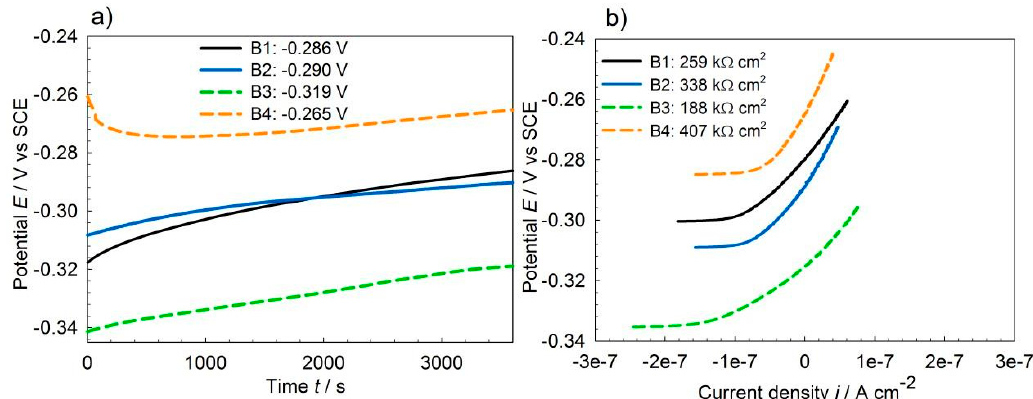
Figure 8. ( a ) Corrosion potential measurements; ( b ) linear polarization measurements; for series B steels in a Na-tetraborate buffer, pH = 10, at a scan rate of 0.1 mV/s.